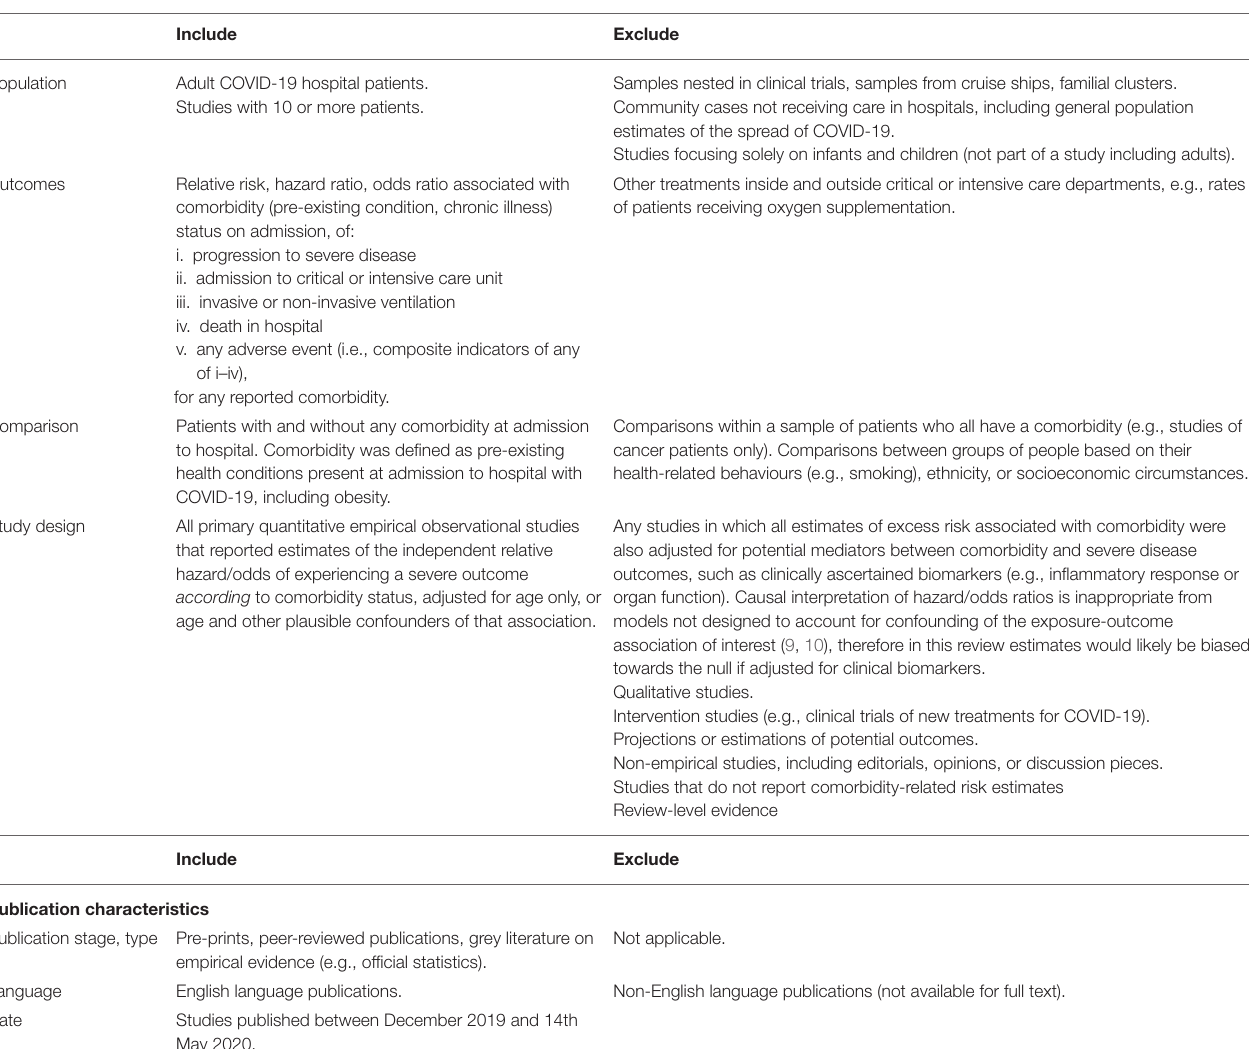
TABLE 1 | Review inclusion and exclusion criteria: what was the age-adjusted association between comorbidities and severe or critical care outcomes in hospital patients with COVID-19 in the early stages of the pandemic? Include Exclude